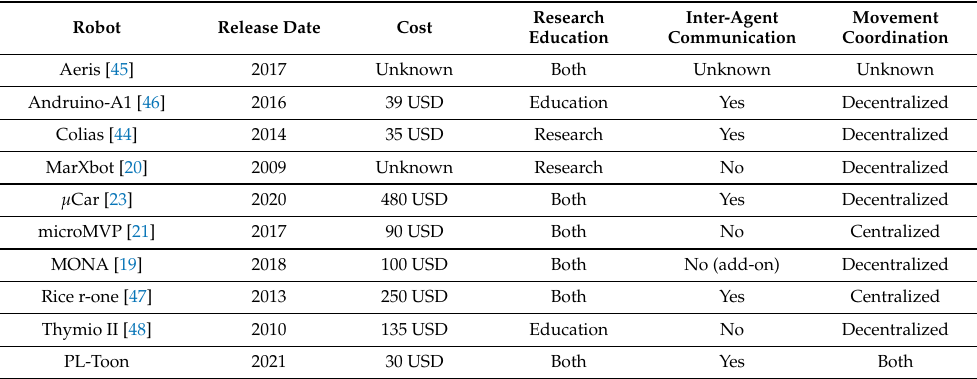
Table 2. Comparison of other non-commercial experimental